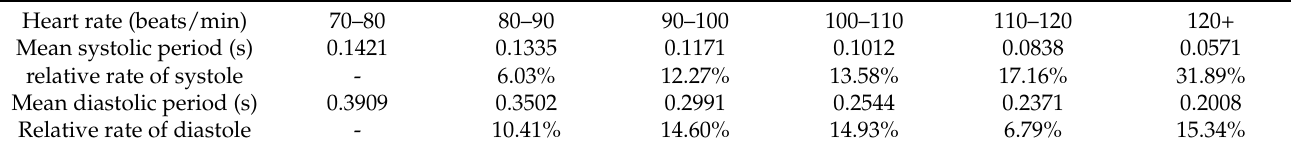
Table 1. Effects of motion on the duration of diastolic and systolic heart sounds.